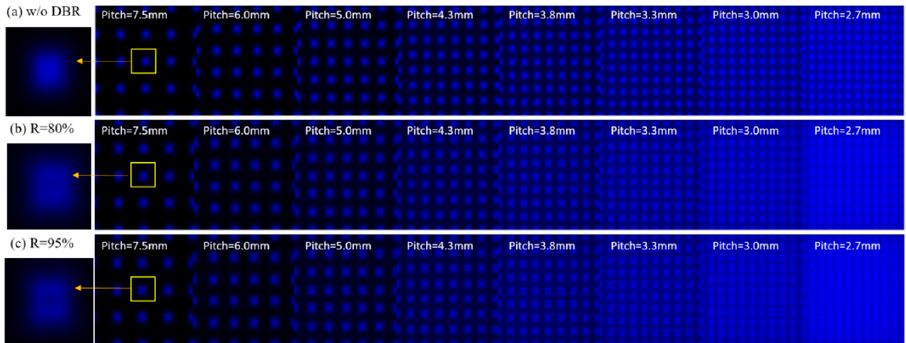
Figure 4. Mini light-emitting diode module (a) without and (b,c) with the DBR.